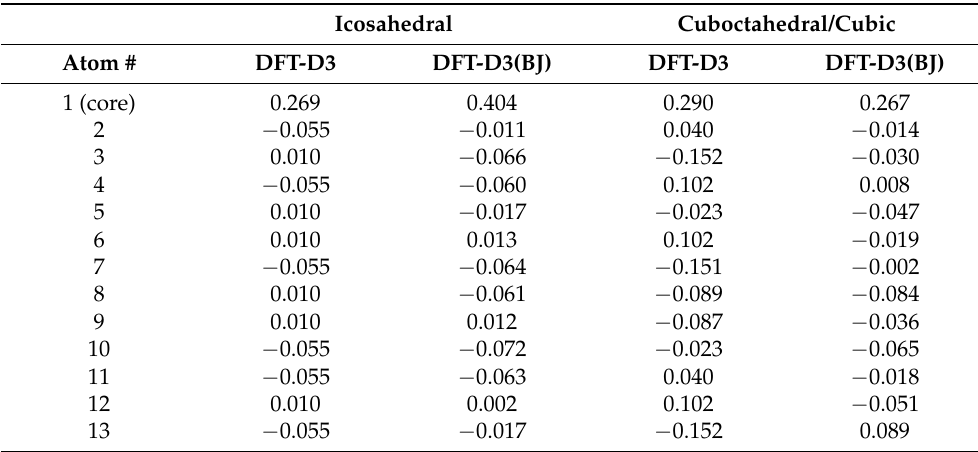
Table 2. Results of the Bader charge analysis ( ∆ q/e − ) of the smallest system (Ru 13 ) for the icosahedral, cuboctahedral/cubic nano-dots, from DFT-D3 and DFT-D3(BJ).